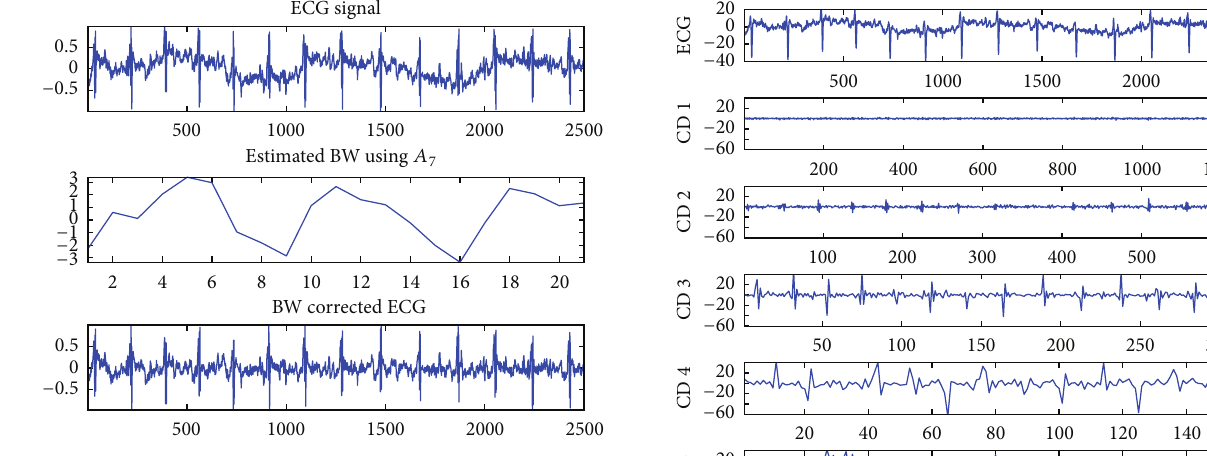
Figure 4: Original ECG signal (DaIsy dataset lead 4), estimated BW from 𝐴 7 , and BW corrected signal.